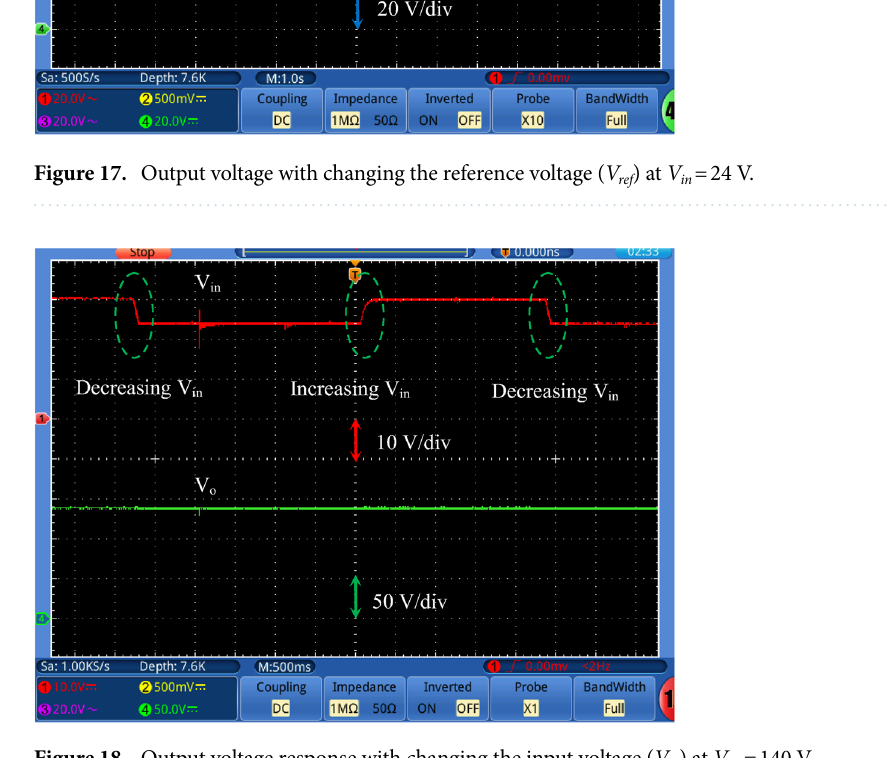
Figure 18. Output voltage response with changing the input voltage ( V in ) at V ref = 140